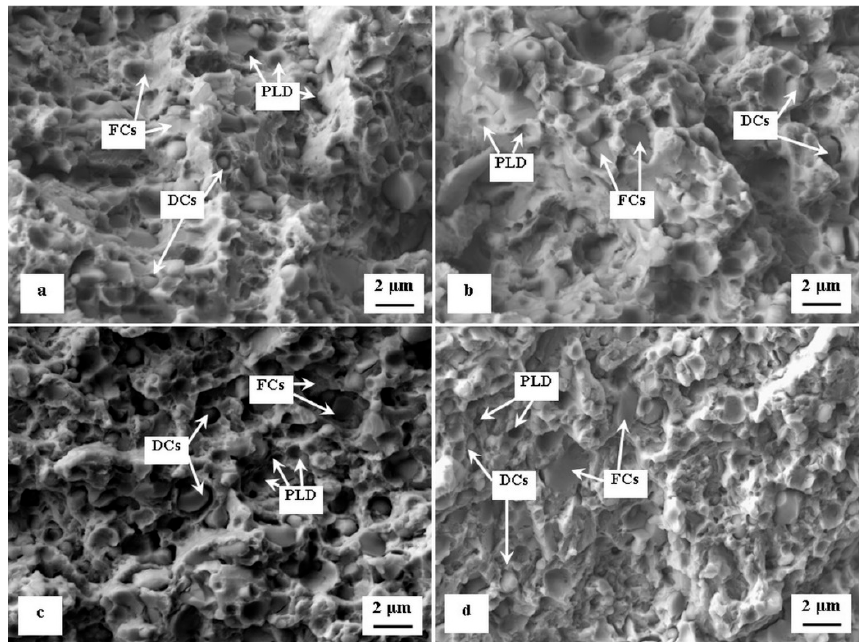
Figure 11. SEM micrographs showing details of fracture surfaces of the broken specimens for flexural strength after tempering at 530 °C: ( a ) CHT, ( b ) SZT at − 140 °C, ( c ) SZT at − 196 °C, and ( d ) SZT at − 269 °C.